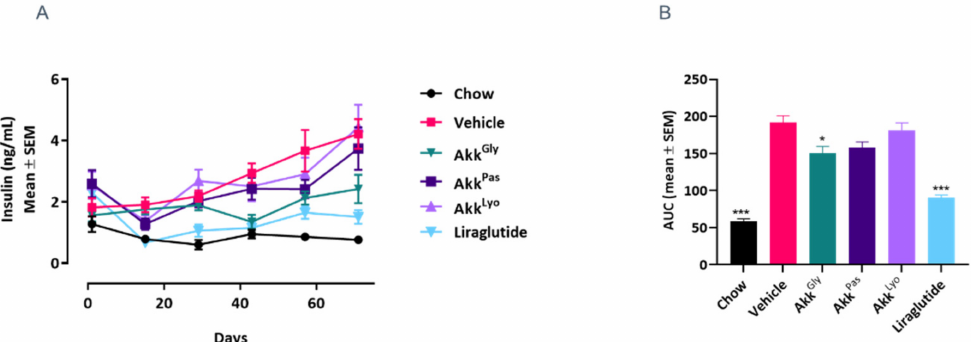
Figure 8. Akkermansia sp. DSM33449 modulates the insulin levels in a DIO mouse model ( n = 10). ( A ) Serum insulin levels of animals fed on a standard chow (Chow) or high-fat diet (HFD) and treated by oral gavage with a solution of vehicle (PBS + Glycerol) or Akkermansia sp. DSM 33459 frozen (Akk Gly ) or pasteurized (Akk Pas ) or lyophilized (Akk Lyo ) for 12 weeks. ( B ) AUC for serum insulin levels. Data are presented as mean ± SEM. *, p < 0.05; ***, p < 0.001, compared to